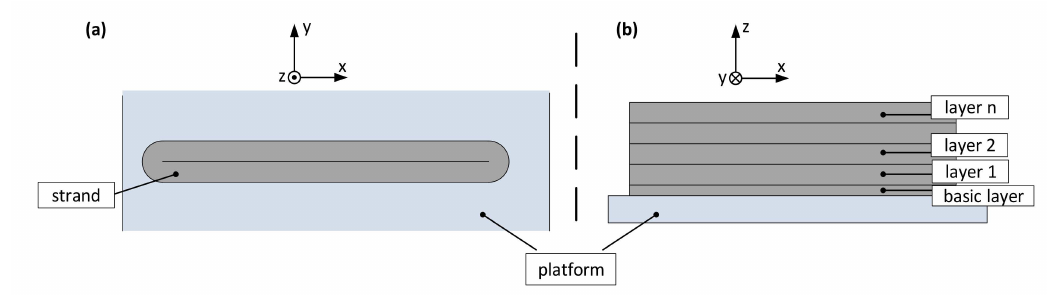
Figure 3. Test procedure—stacking double strands with 3D printing: ( a ) the top view and ( b ) the side view.